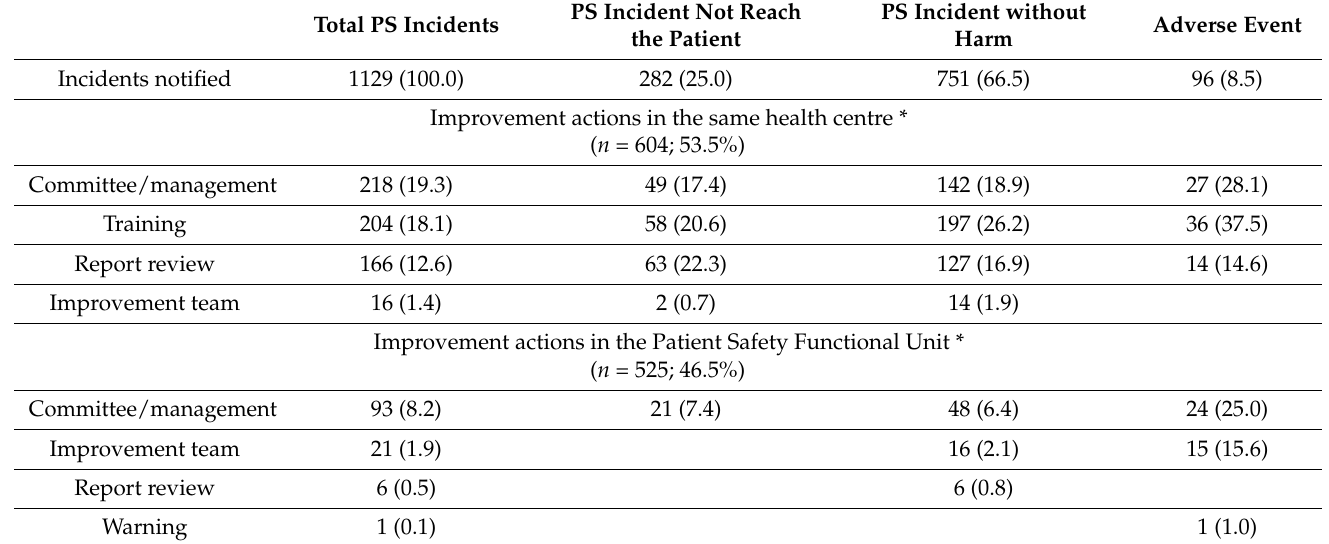
Table 5. Distribution of type of incidents notified based on improvement